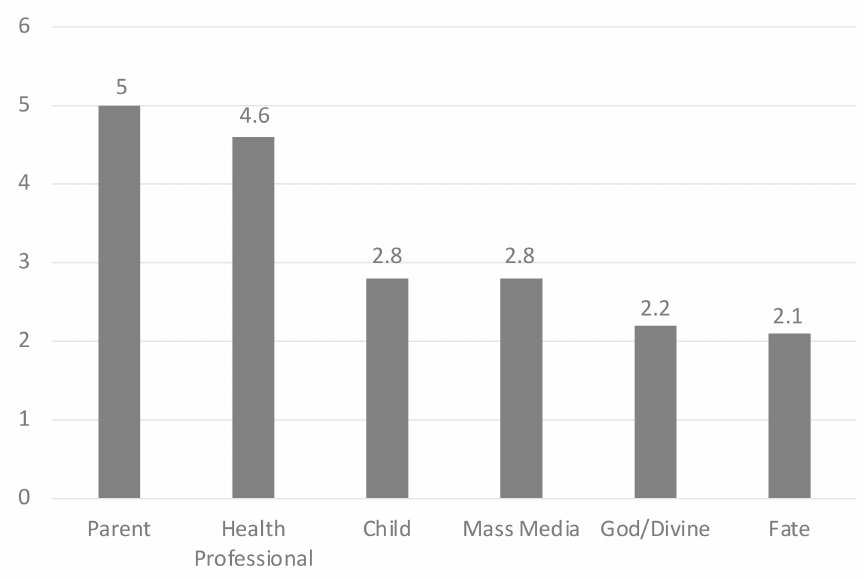
Figure 2. PHLOC sale categories and their mean Likert